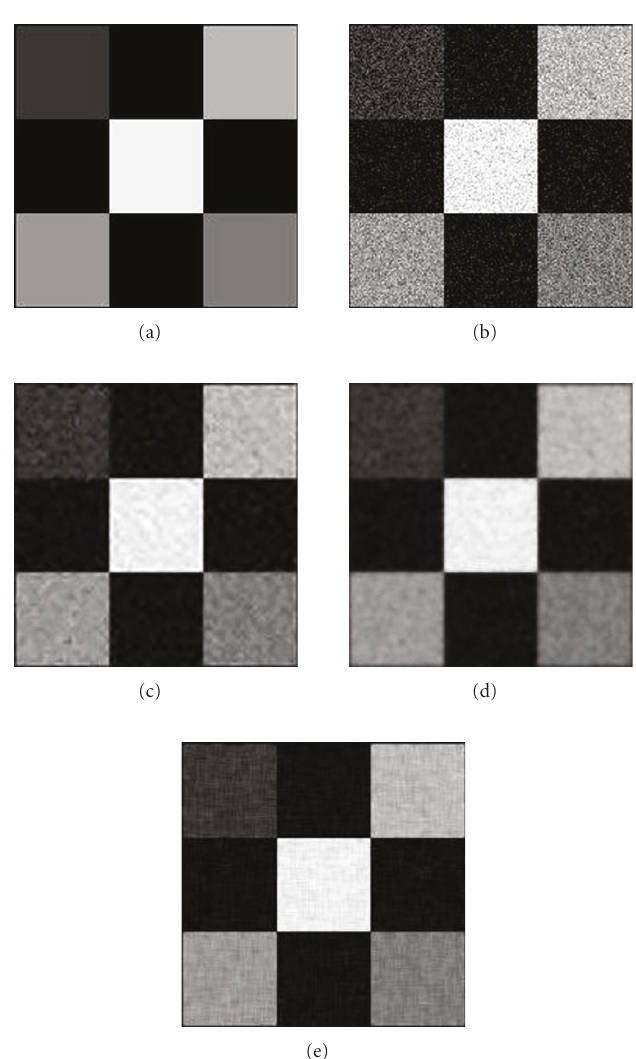
Figure 8: (a) “Nine Square Regions”, (b) noisy image with Gaussian noise with σ = 0 . 01, (c) wavelet, PSNR = 25 . 493, (d) ADF, PSNR = 23 . 835, and (e) the proposed procedure, PSNR = 28 .